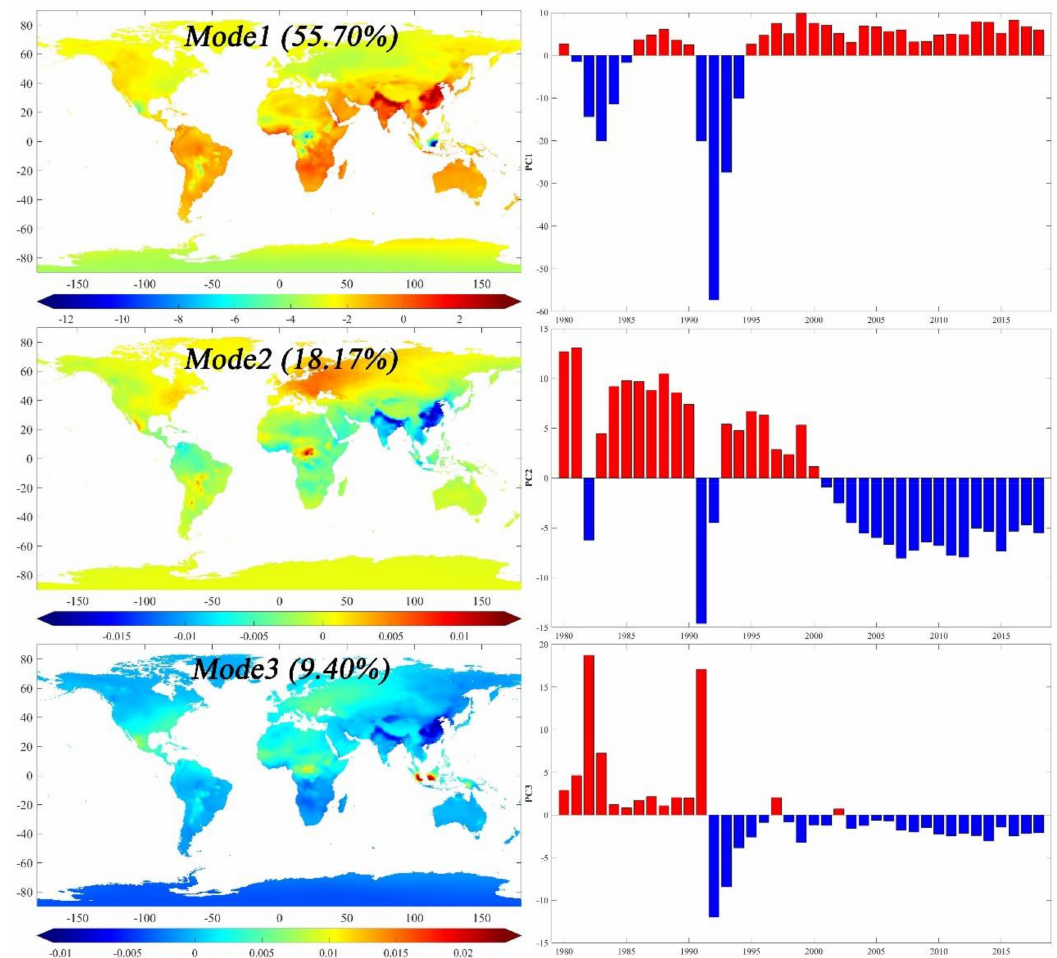
Figure 5. First three leading modes of the empirical orthogonal function analysis (EOF).